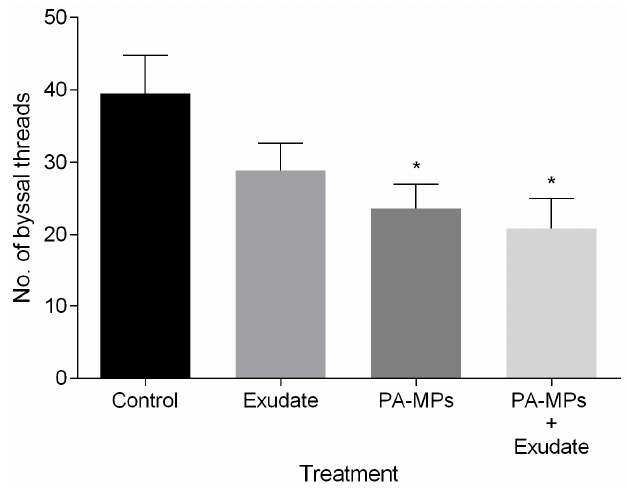
Figure 5. Number of produced byssal threads by Mytilus galloprovincialis during the 96 h exposure to different treatments: (i) control (0%; 0 mg/L); (ii) A. armata exudate (2%); (iii) PA-MPs (1 mg/L); and (iv) A. armata exudate (2%) and PA-MPs (1 mg/L). All values are presented as mean ± SEM. * denotes a significant difference compared with the control treatment.